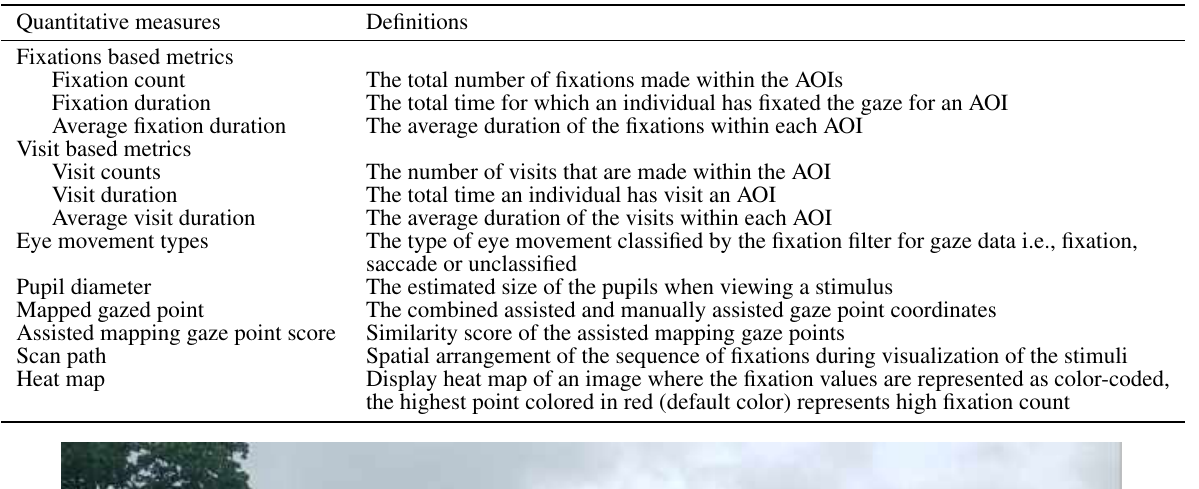
Table 2. Different types of quantitative metrics for eye-tracking.